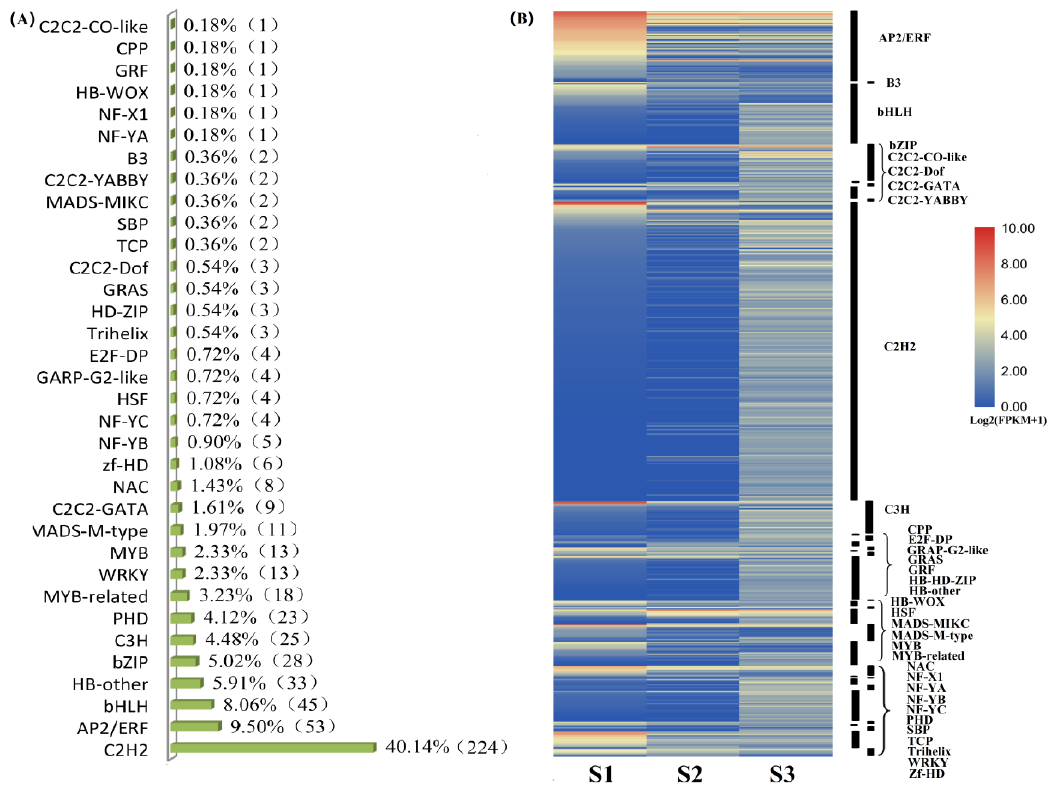
Figure 6. Analysis of transcription factors of DEGs. ( A ) Statistics of transcription factor families. Percentage refers to the ratio of the number of members of each transcription factor family to the total number of members of all celery transcription factors. ( B ) Expression of transcription factors at different flower development stages. FPKM-values were log2 (FPKM+1)-based. Red, yellow, and blue represent high, medium, and low expression levels, respectively.